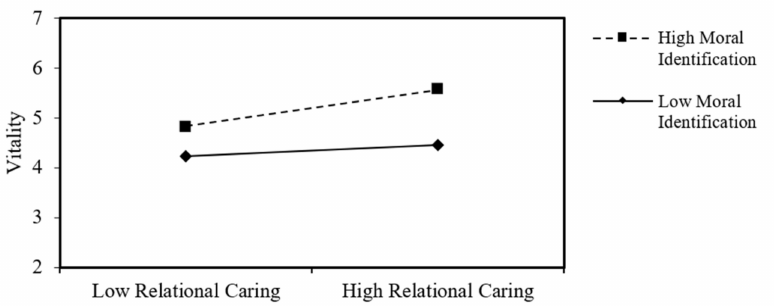
Figure 1. The moderation effect of a moral